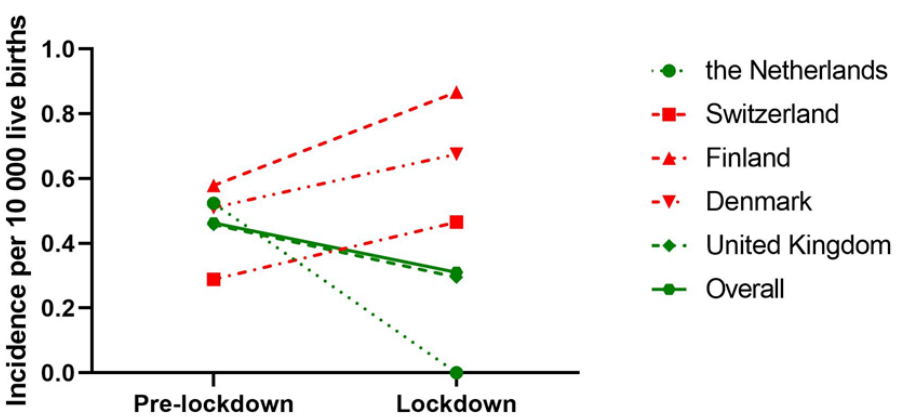
Figure 3. Incidence of IBA prior (January 2015–March 2020) and during the lockdown (March 2020–June 2020) of countries where BA care is centralised. Incidence is expressed as number of IBA patients per 10,000 live births. Different symbols represent different countries and dashed lines represent countries, while the connected line represents overall incidence of all countries. Green lines indicate a decrease in IBA incidence from pre-lockdown to lockdown period, while a red line indicates an increase. Table 3. Results of logistic binominal regression analysis of IBA incidence prior and during the strict COVID-lockdown per participating country. Odds ratios (OR) are shown which indicates the odds of acquiring IBA during the strict COVID- lockdown, using the odds of acquiring IBA prior to the COVID-lockdown as reference category. Colours represent a range of stringency index where green is the relatively highest and red the relatively lowest.